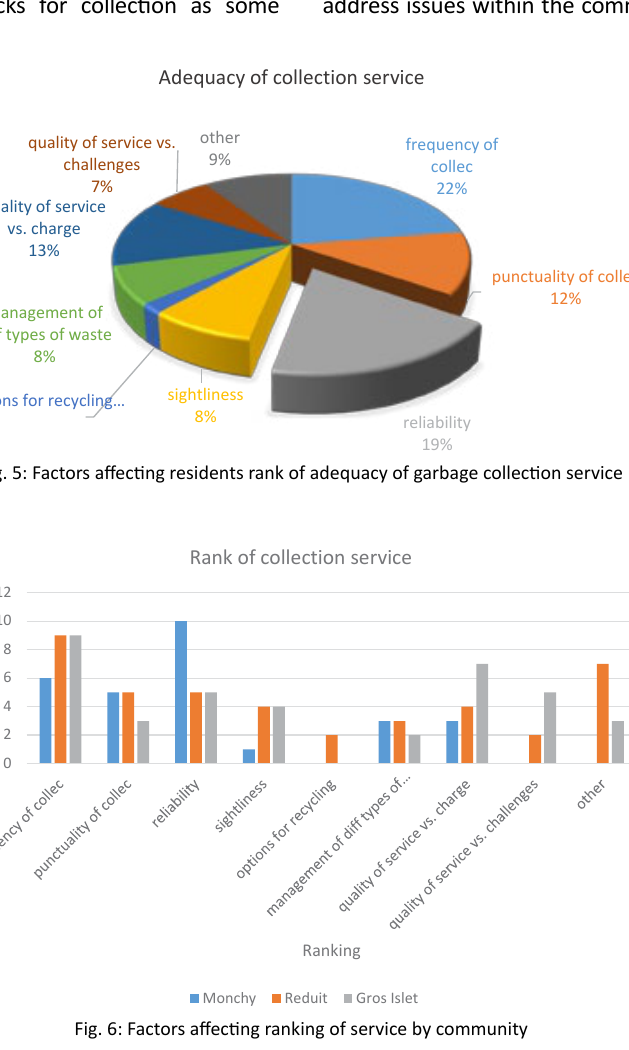
Fig. 6: Factors affecting ranking of service by community